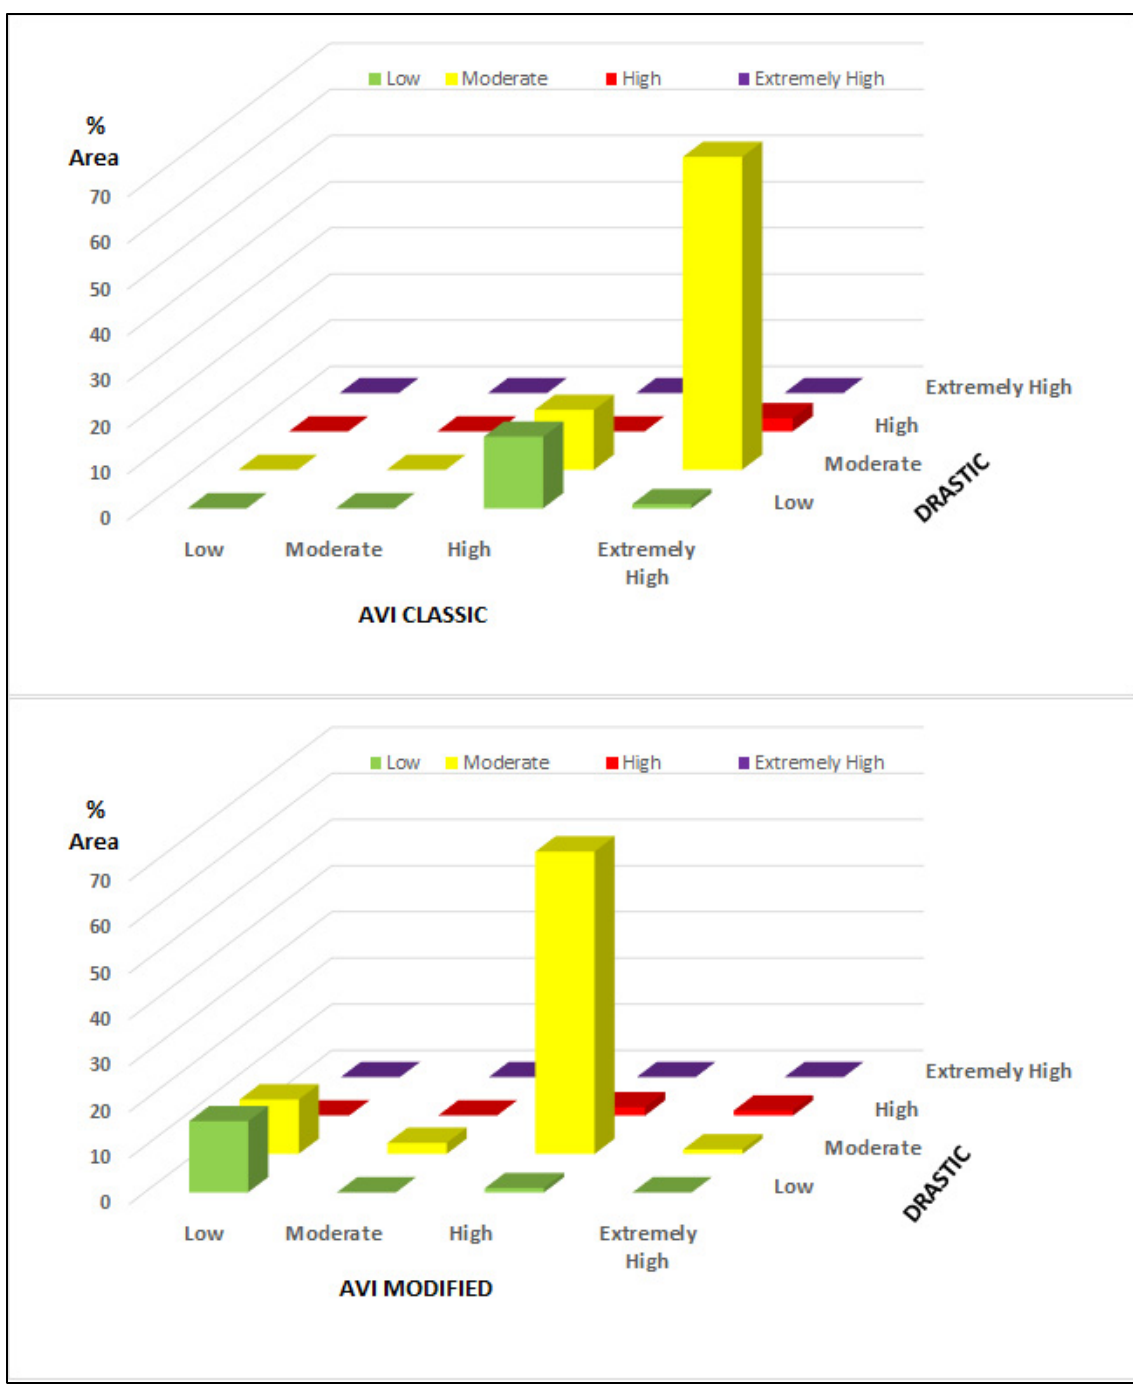
Figure 9. The 3D histogram showing the comparison of the areas as a percentage of the vulnerability classes between the maps when evaluated using the DRASTIC method and the AVI methods (classic and modified) for the Campanian Plain-Acerra area.